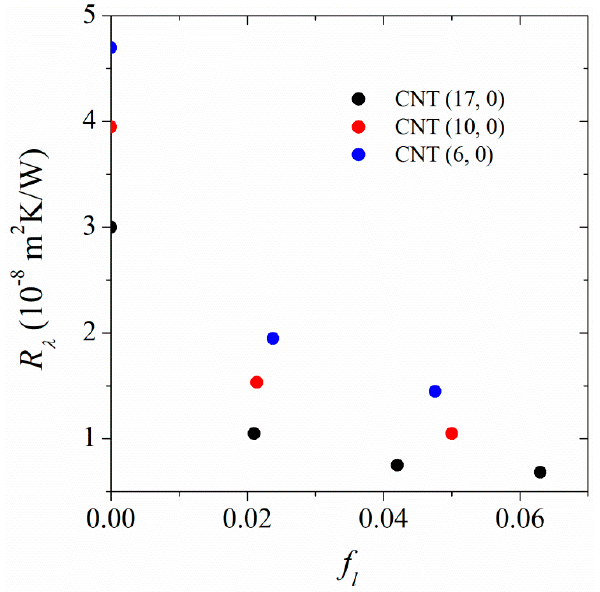
Figure 7. Dependence of CNT-PA-6,6 interfacial thermal resistance (Kapitza resistance) on the linkage fraction.